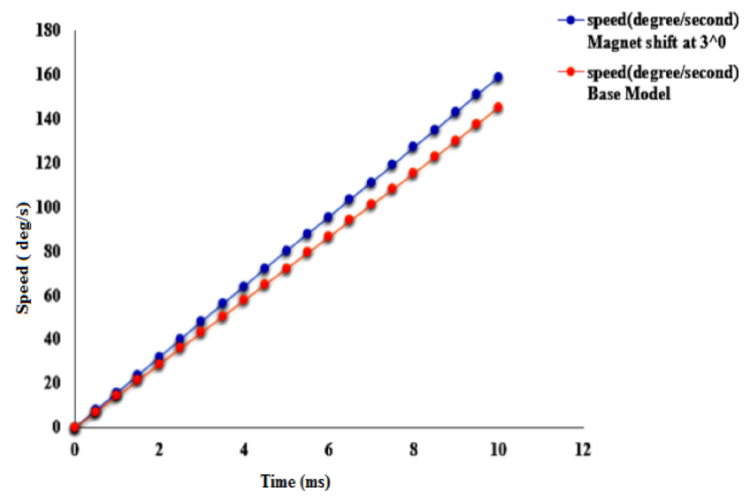
Figure 14. Speed vs. time.